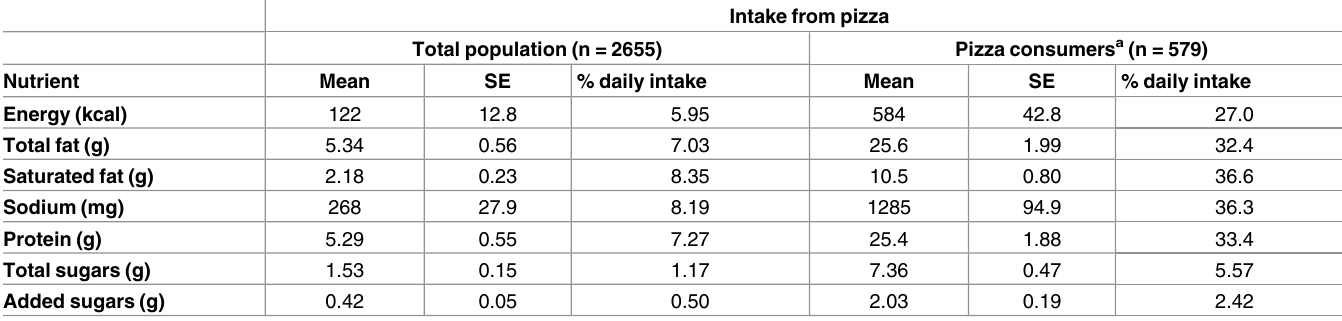
Table 2. Mean daily intake from pizza products in NHANES 2011–12children and adolescents aged 4 to 19 years (Day 1).